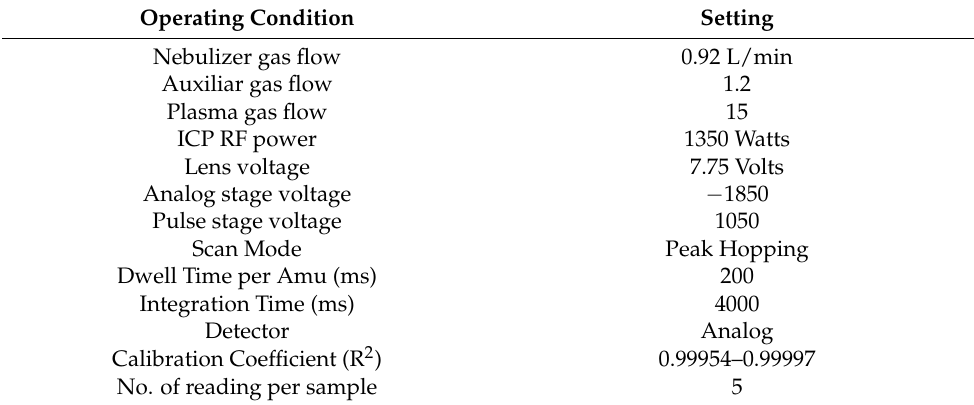
Table 2. Used ICP-MS parameters for optimization of Li